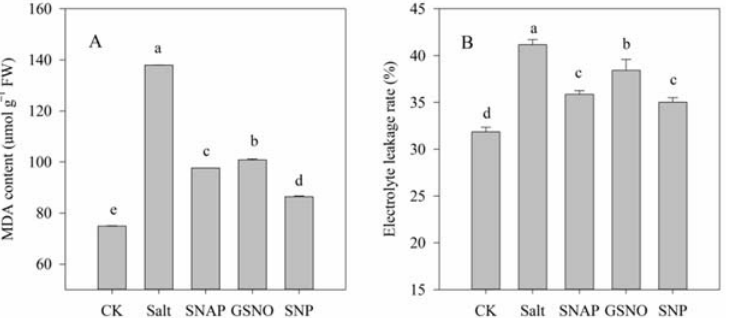
Figure 2. Malondialdehyde (MDA) content ( A ) and the relative electrolyte leakage rate ( B ) of C. paliurus leaves under different treatments. CK (control, distilled water), salt (100 mM NaCl), SNAP (100 mM NaCl with 0.05 mM SNAP), GSNO (100 mM NaCl with 0.05 mM GSNO), SNP (100 mM NaCl with 0.05 mM SNP). Bars represent standard deviation (SD) of the means. Different letters suggest significant differences among the treatments at p < 0.05 (Duncan’s test).